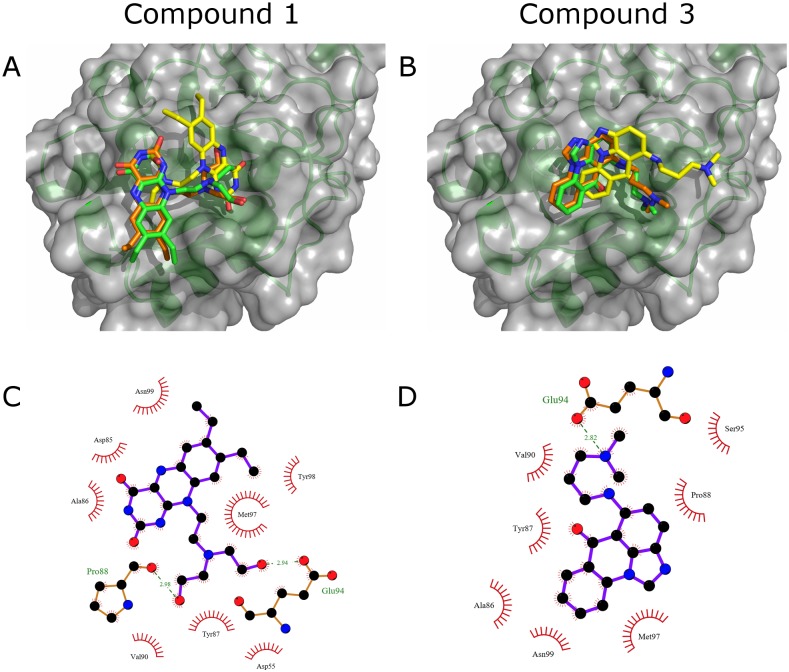
Top binding poses of compounds 1 and 3 from composite docking.Top binding poses of the most potent collagenase inhibitors, 1 (A) and 3 (B), as docked using the three docking methods. The poses are depicted using sticks and colored orange (Glide), green (Surflex), and yellow (GOLD). Ligplot diagrams depicting the predicted binding of compounds 1 (C) and 3 (D) into ectosteric site 1 using the best binding pose calculated from Glide. Hydrogen bonds with the binding site residues are highlighted in green with the respective distances and hydrophobic interactions are shown with red dashes.